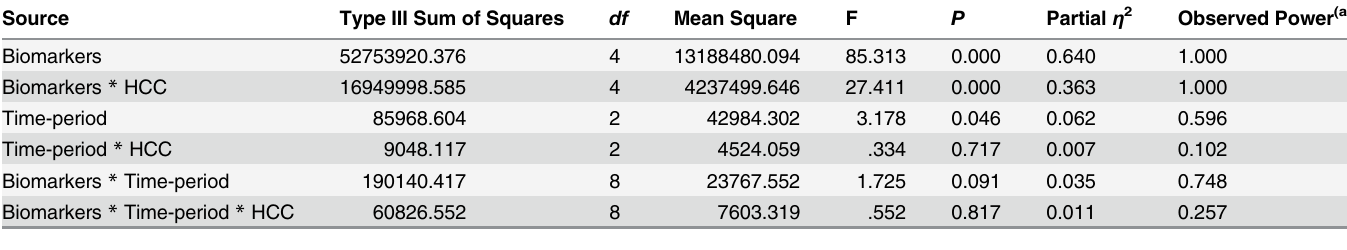
Table 4. Results of the tests of within-subjects effects on biomarkers and time in living donor liver transplantation with hepatocellular carcinoma recurrence.